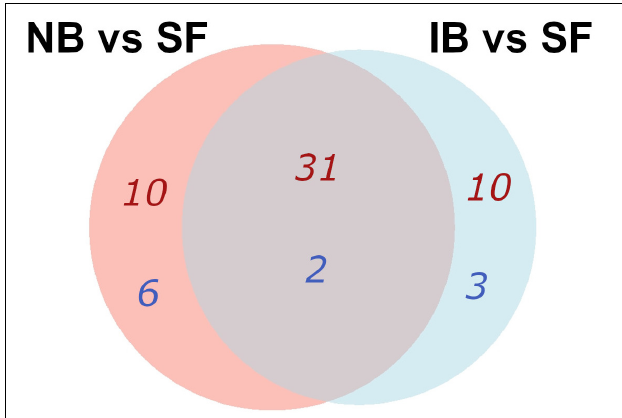
FIGURE 2 | Venn diagram of KEGG pathways enrichment that were common and specific for the pairwise comparisons, using the differentially expressed genes (DEGs) orthologs of Ae. aegypti in the two comparison groups. The number of pathways up- in red, down- in